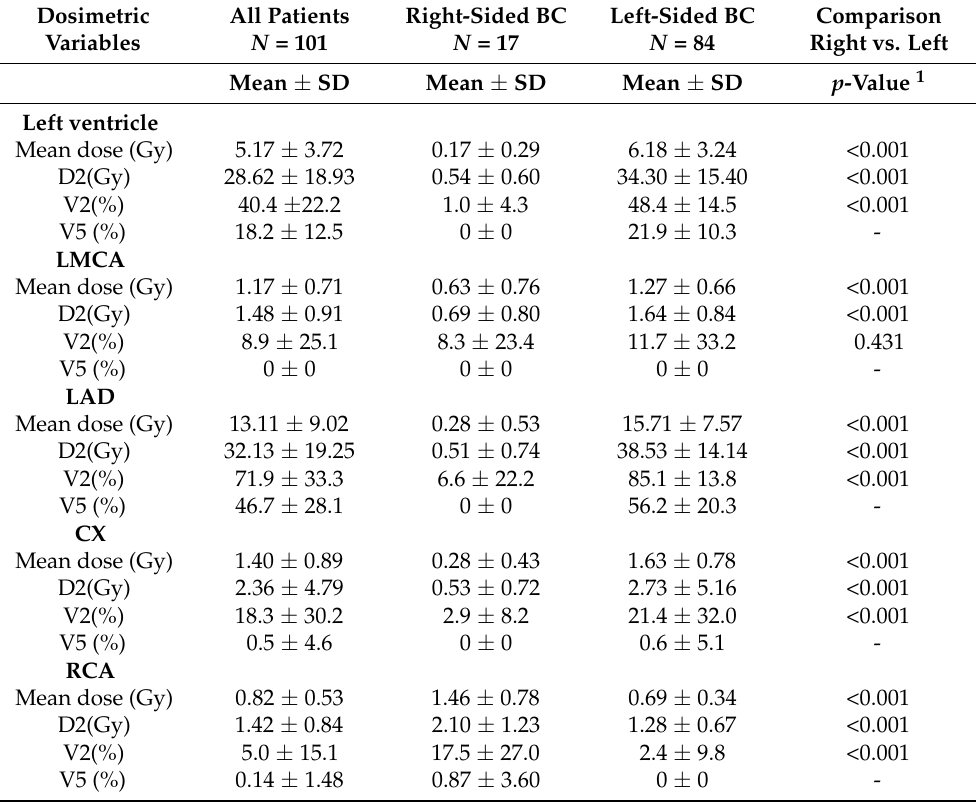
Table 2. Cont. Dosimetric Variables